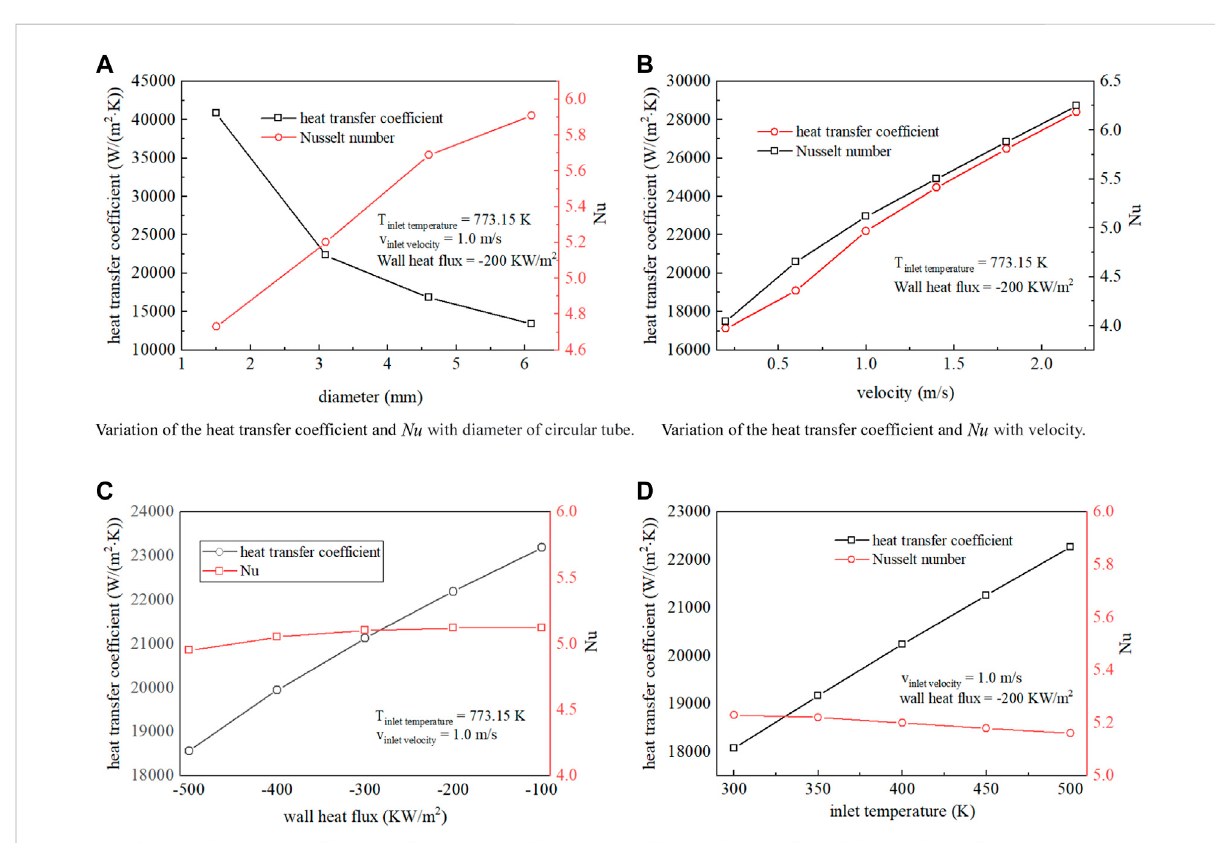
FIGURE 8 Variation of Nu along the circular